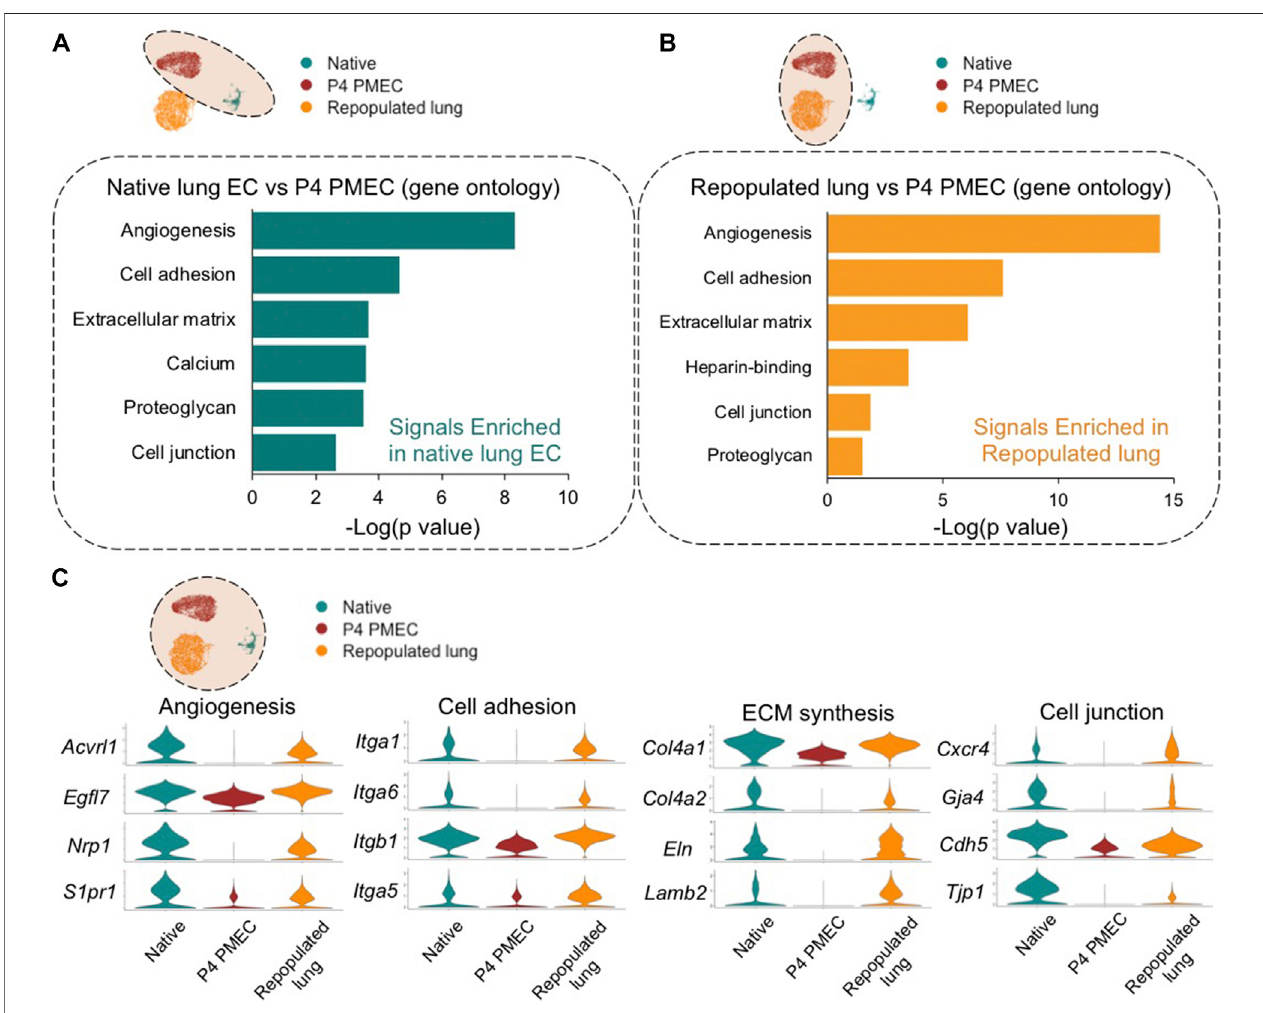
FIGURE 3 | Global comparison amongst Native, P4 PMEC, and Repopulated lung. (A,B) Gene ontology analysis shows the top upregulated signals based on the top DEGs of comparisons between Native endothelium and P4 PMEC (A) , and between Repopulated lung and P4 PMEC (B) . (C) VlnPlots of representative genes of angiogenesis, cell adhesion, ECM synthesis, and cell junction in the merged dataset of Native, P4 PMEC, and Repopulated lung samples.